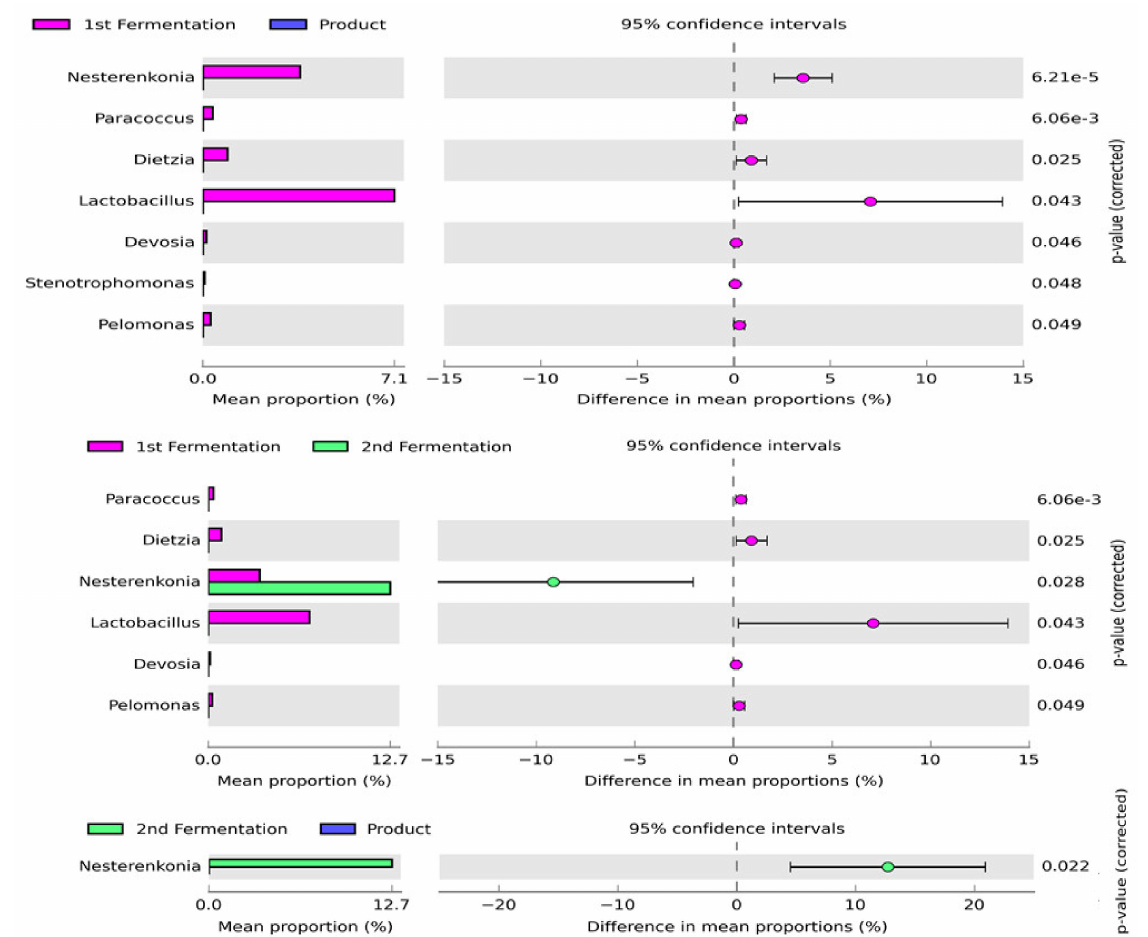
Figure 3. Enriched bacterial genera across the fermentation stages and in the final product. The left panel of these figures shows the abundance of differentially enriched bacterial genera. The right panel represents the significant dif- ference at p < 0.05. The middle panel indicates the mean proportion of differentially enriched bacterial genera at a 95% confidence